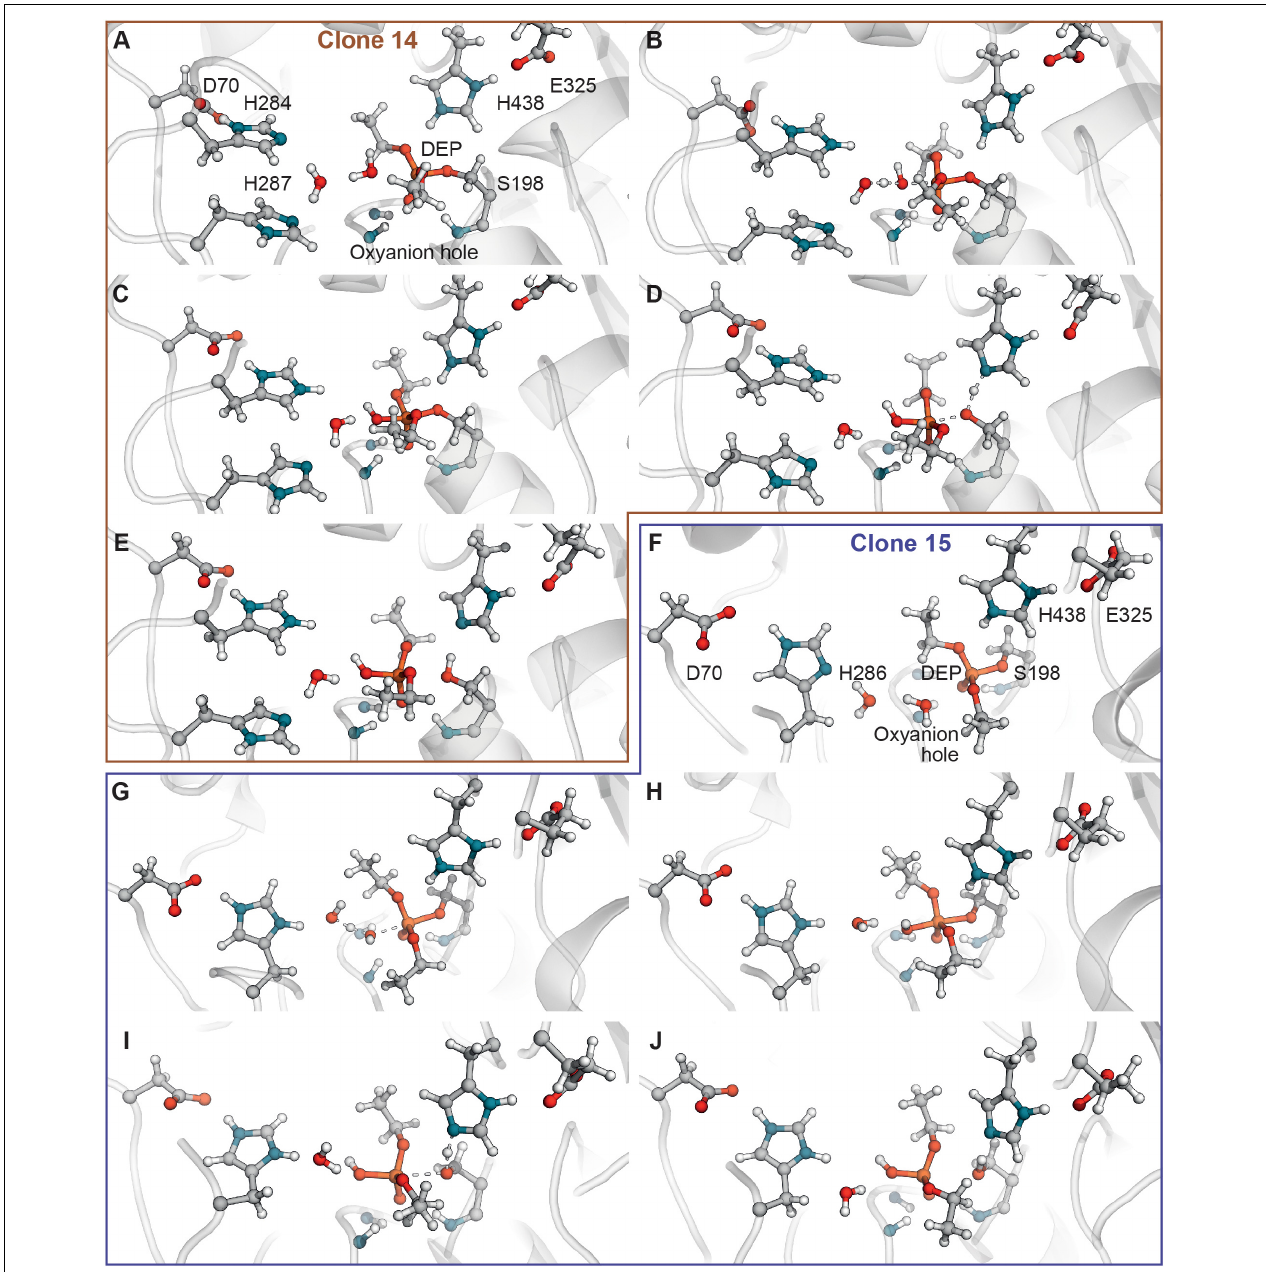
FIGURE 3 | Computer analysis of the catalytic mechanism of paraoxon hydrolysis by selected BChE variants. (A–E) Snapshots of the reactivation reaction path of paraoxon hydrolysis by clone 14. (F–J) Snapshots of the reactivation reaction path of paraoxon hydrolysis by clone 15.